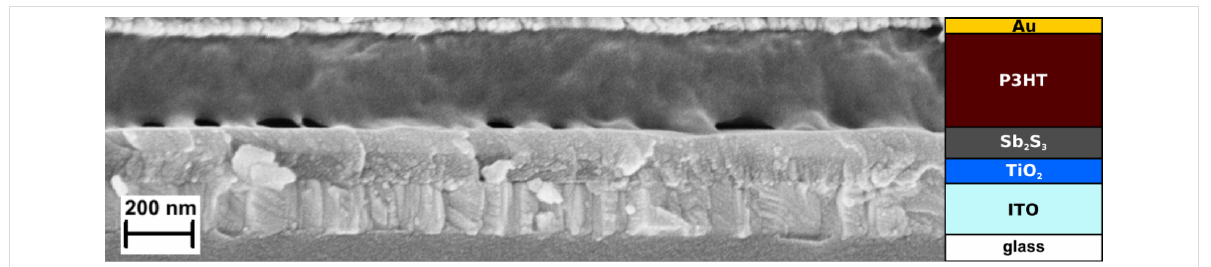
Figure 4: SEM cross-section of the best-performing 5.5% PCE solar cell (100 nm Sb 2 S 3 ) and the corresponding device schematic.